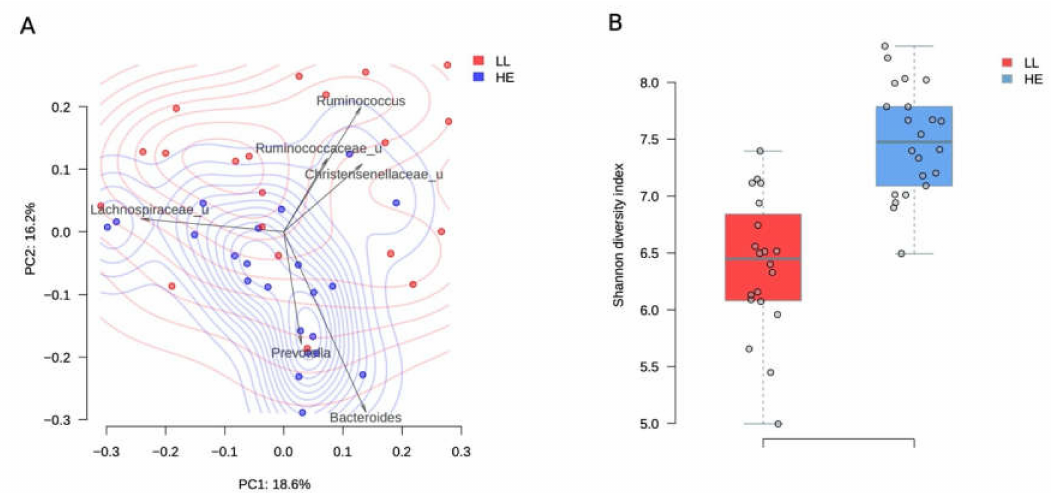
Figure 1. Comparison between long-livers and healthy adults from a Russian population. A-PcoA (Principal Coordinates Analysis) of Russian long-livers (blue dots) and healthy elderly participants (red dots) samples using the Bray–Curtis dissimilarity metric. Arrows show the top taxa in terms of the explained variance in given axes. The arrows’ length is proportional to the percent of variance explained by the taxon. The arrows’ angle reflects the distribution of this variance between the axes. B-Gut microbiota Shannon alpha-diversity indices in long-livers ( A ) and conditionally healthy elderly participants ( B